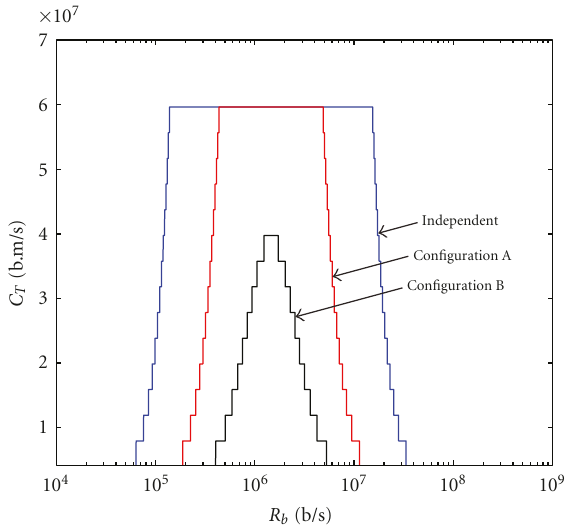
Figure 7: C T versus R b for 16-QAM modulation with three Nakagami- m fading channels using 3D node distribution ( m = 1, K = 3).